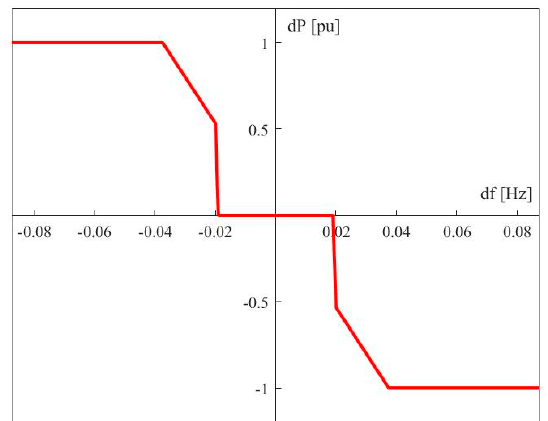
Figure 1. Droop control curve based on the Italian Grid Code implemented in the battery energy storage system (BESS) model for Frequency Containment Reserve (FCR) provision. Table 1. Droop curve data.